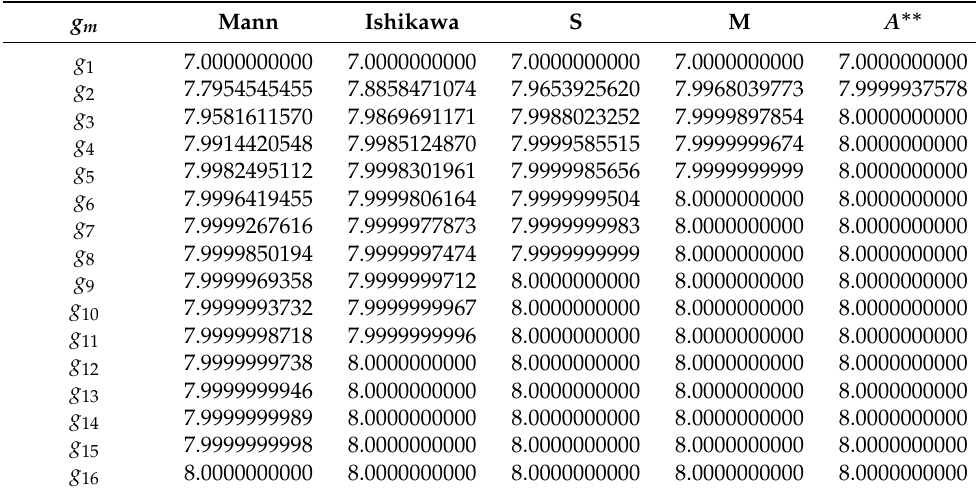
Table 1. Comparison of speed of convergence of the A ∗∗ iteration method with some known itera- tion methods.